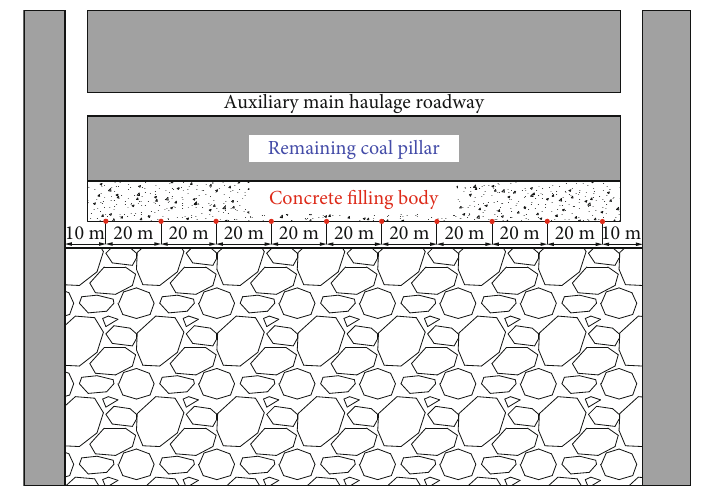
Figure 17: The schematic diagram of measuring point